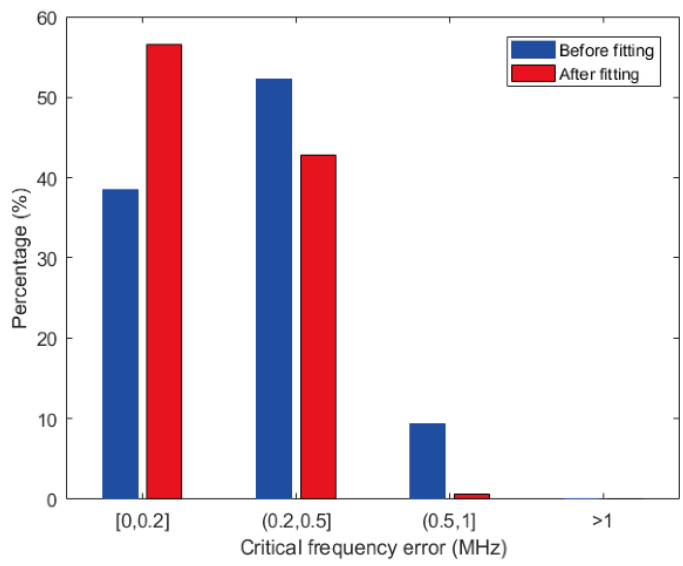
Figure 8. Error statistics of the inversion results.